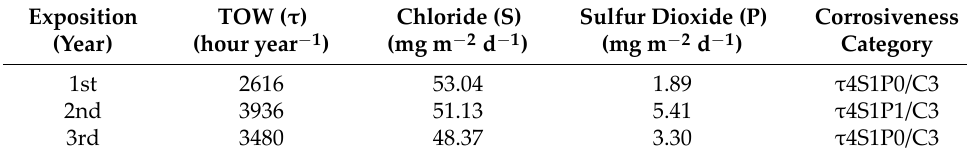
Table 1. Environmental Corrosivity Category Classification.